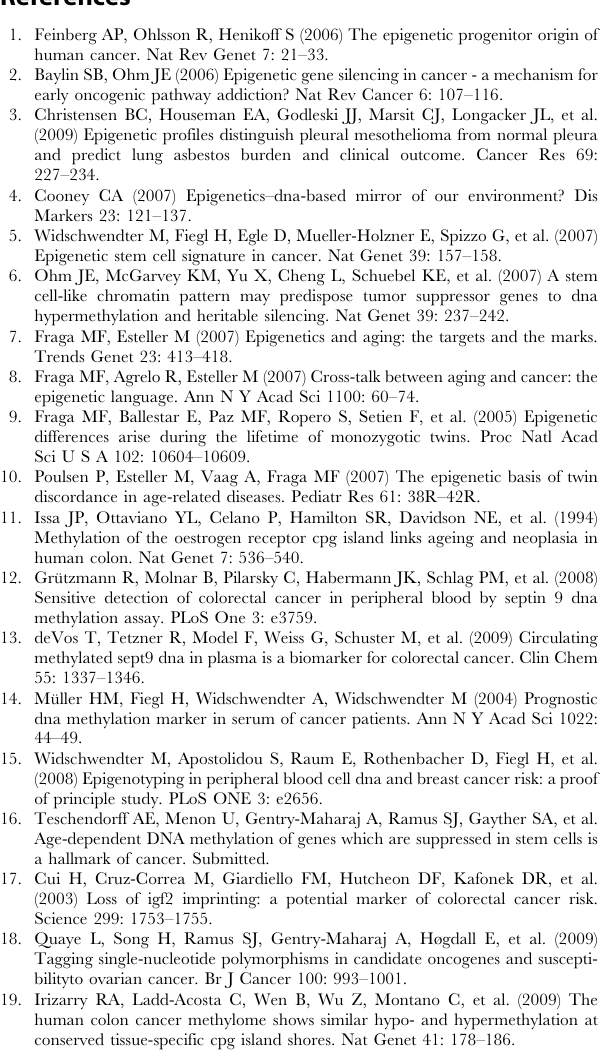
Table S4 Enrichment analysis of genes undergoing age and cancer specific DNAm changes and genes upregulated in major blood cell-types.